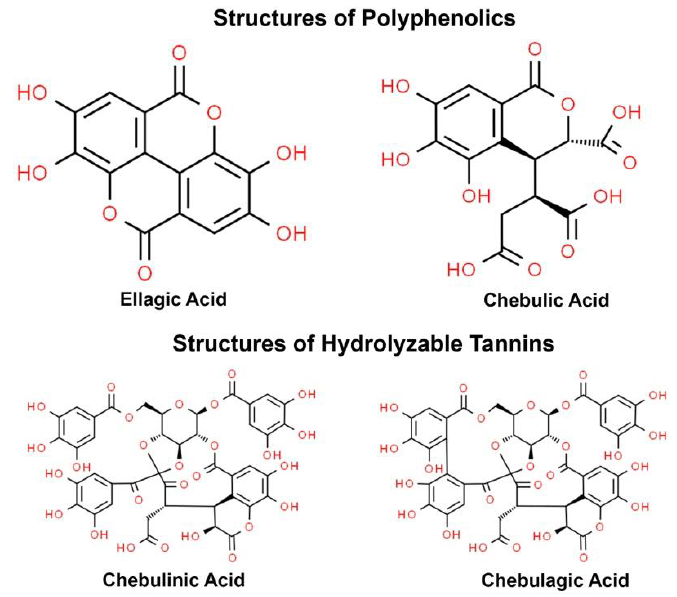
Figure 1. Chemicals structures of ellagic acid, chebulic acid, chebulinic acid, and chebulagic acid that are found in the standardized extract of Terminalia chebula .